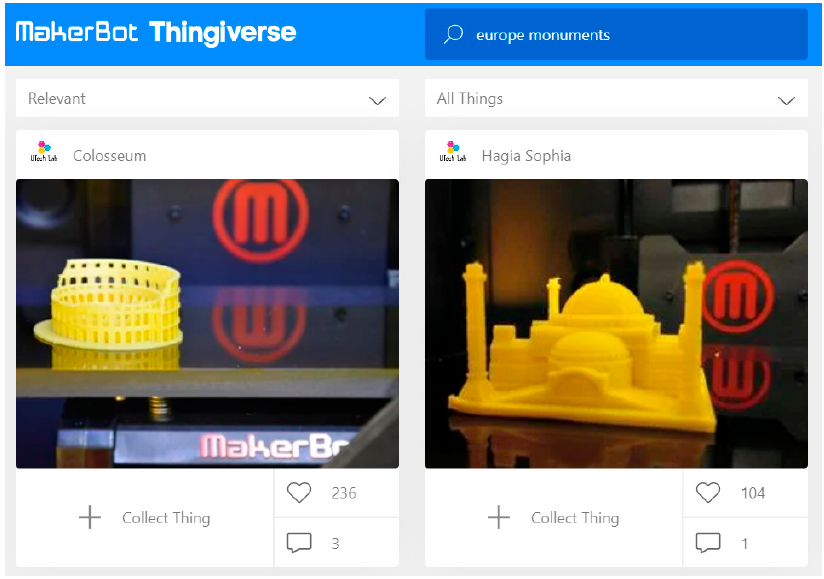
Figure 3. Thingiverse [46] interface to choose and download 3D models.